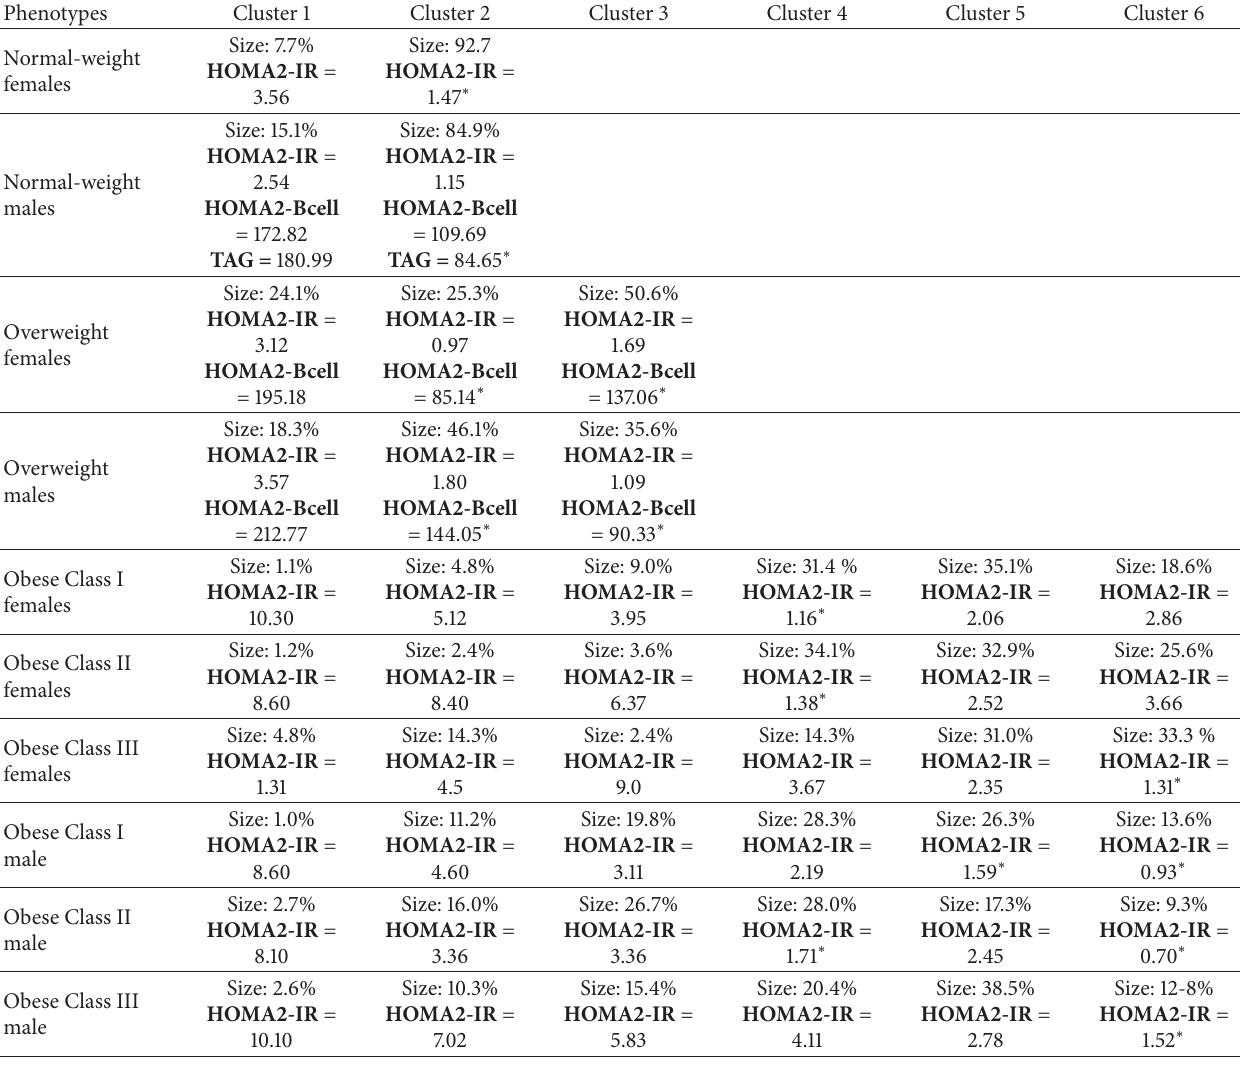
Table 1: Risk factors aggregation according to Cluster Analysis and derivatives clusters. Maracaibo City Metabolic Syndrome Prevalence Syndrome,